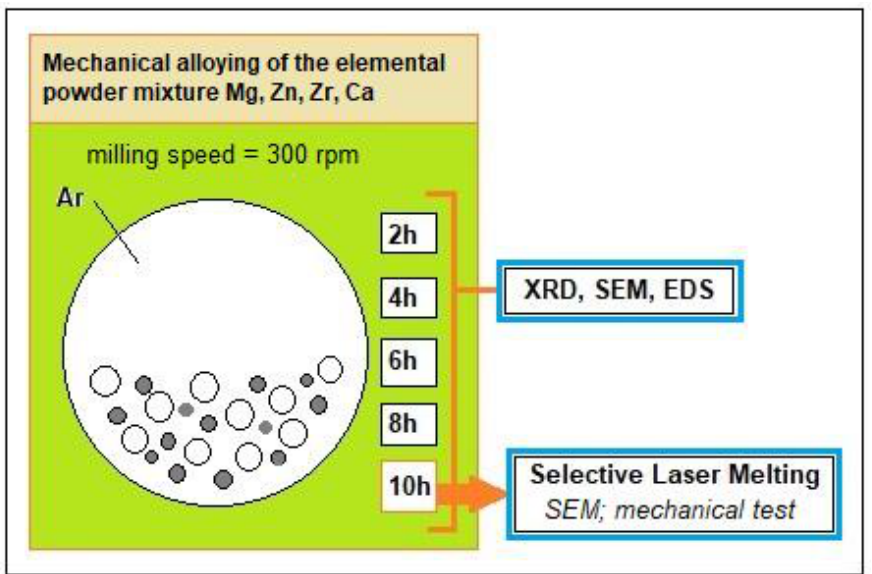
Figure 1. The schema of the experimental procedures and of corresponding analyses applied on the studied Mg-Zn-Zr-Ca powder-alloy.